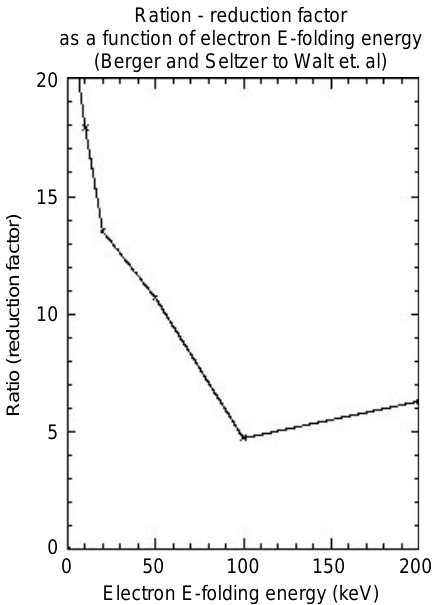
Fig. 7. The reduction factor for calculating the X-rays emitted at 135 (cid:14) , nadir angle (Walt et al. , 1979) from the X-rays emitted into the upward hemisphere (Seltzer and Berger, 1974). The reduction factor is interpolated linearly between our five values from